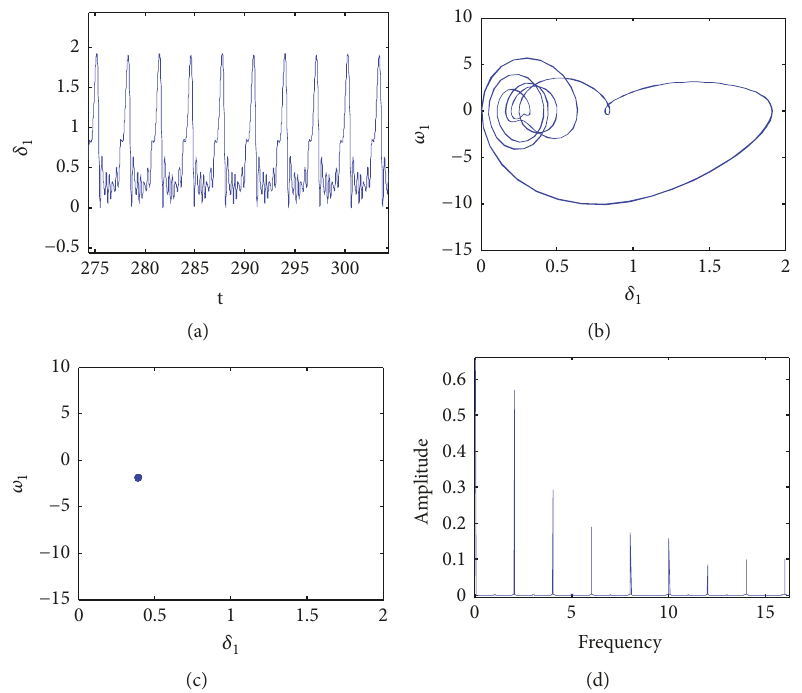
Figure 14: Period 1 motion (D=0.01). (a) Time history. (b) Phase portrait. (c) Poincar´e map. (d) Frequency spectrum.